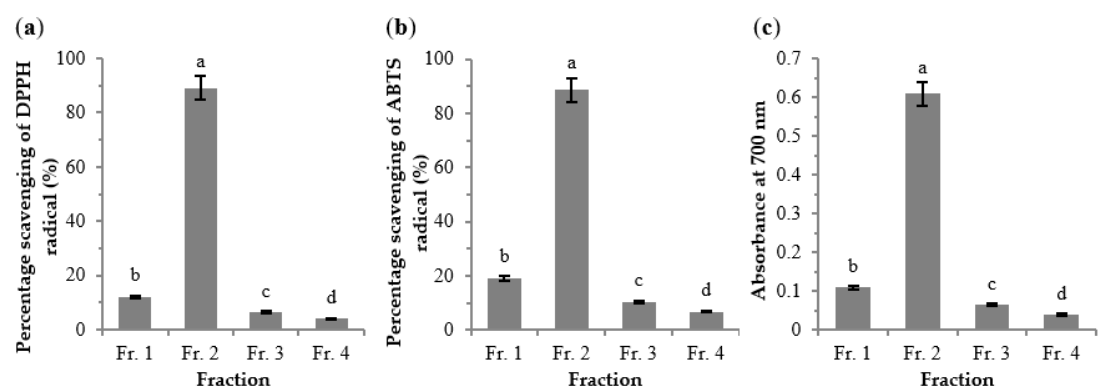
Figure 2. Antioxidant activities of the four fractions ( c = 0.5 mg/mL) eluted from D101 resin column by DPPH radical ( a ), ABTS radical ( b ), and reducing power assay ( c ). The results are expressed as mean ± standard deviation ( n = 3). Different letters above each bar within the same figure indicate significant differences ( p < 0.05).